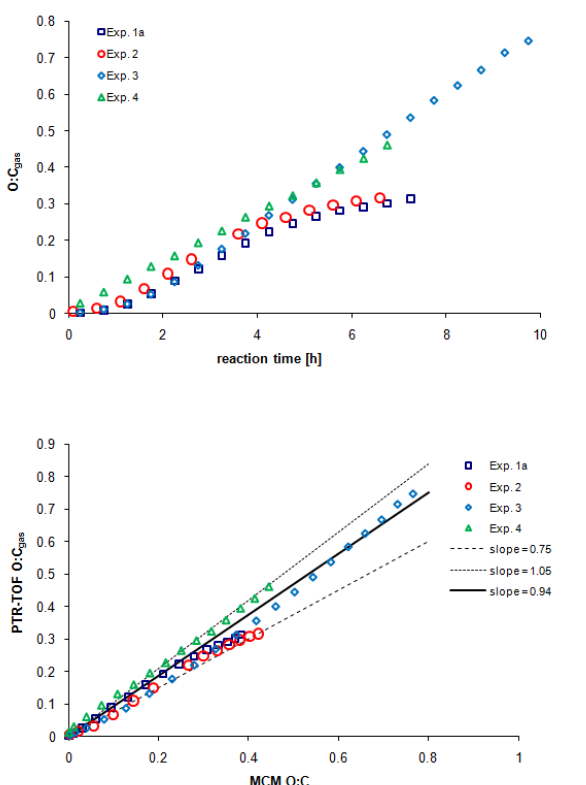
Fig. 7. (a) Time evolution of total O:C gas ratios measured with the Figure 7. a) Time evolution of total O:C gas ratios measured with the PTR-TOF 600 during 3 PTR-TOF 600 during experiments 1a, 2, 3 and 4. (b) Linear regres- experiments 1a, 2, 3 and 4. b) Linear regression plot of O:C ratio measurements versus 4 sion plot of O:C ratio measurements versus MCMv3.1 MCMv3.1 simulations. 5